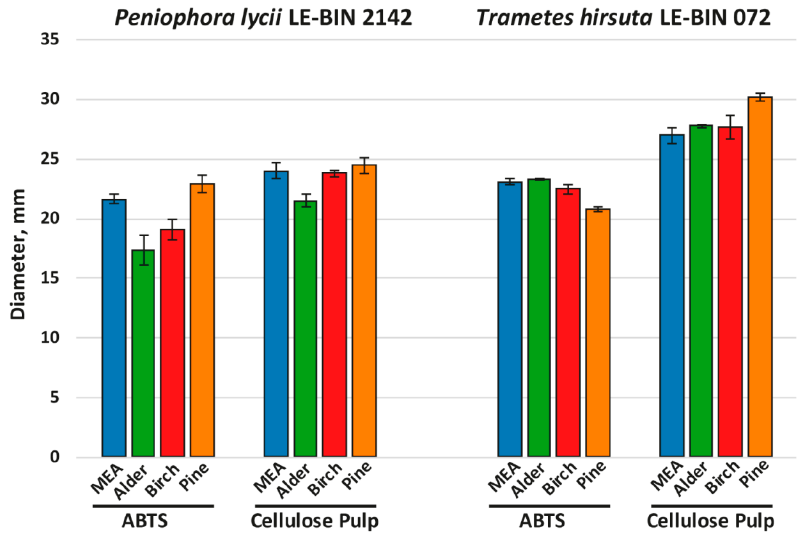
Figure 2. Results of agar plate assays of fungal overall oxidative (ABTS) and cellulolytic (cellulose pulp) activities. Both P. lycii LE-BIN 2142 and T. hirsuta LE-BIN 072 were able to grow on all types of sawdust; however, their growth rates (Figure 1) and appearance of mycelium (Supple- mentary Figure S1) were significantly different. On all media, the growth rates of P. lycii LE-BIN 2142 were smaller than that of T. hirsuta LE-BIN 072. However, both fungi demon- strated the same tendency—the growth rates of each fungus on birch and alder sawdust